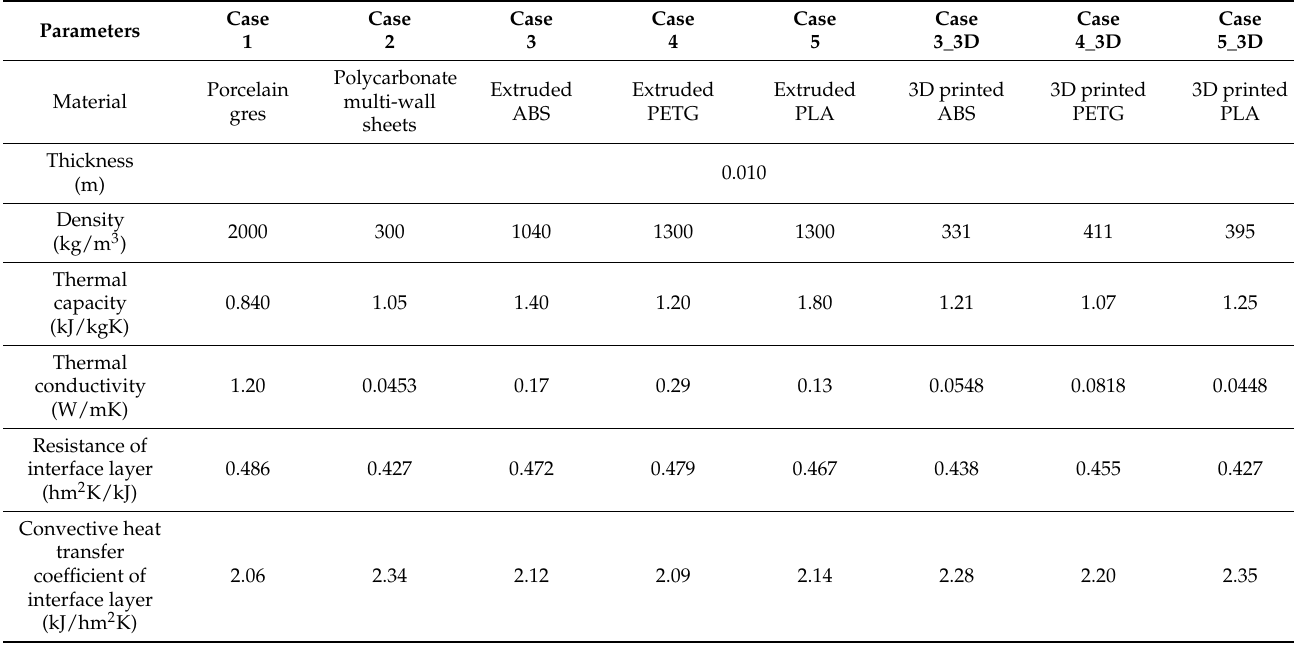
Table 6. Summary of the main simulation parameters for the Type 1230, upon varying the materials used as a second-skin